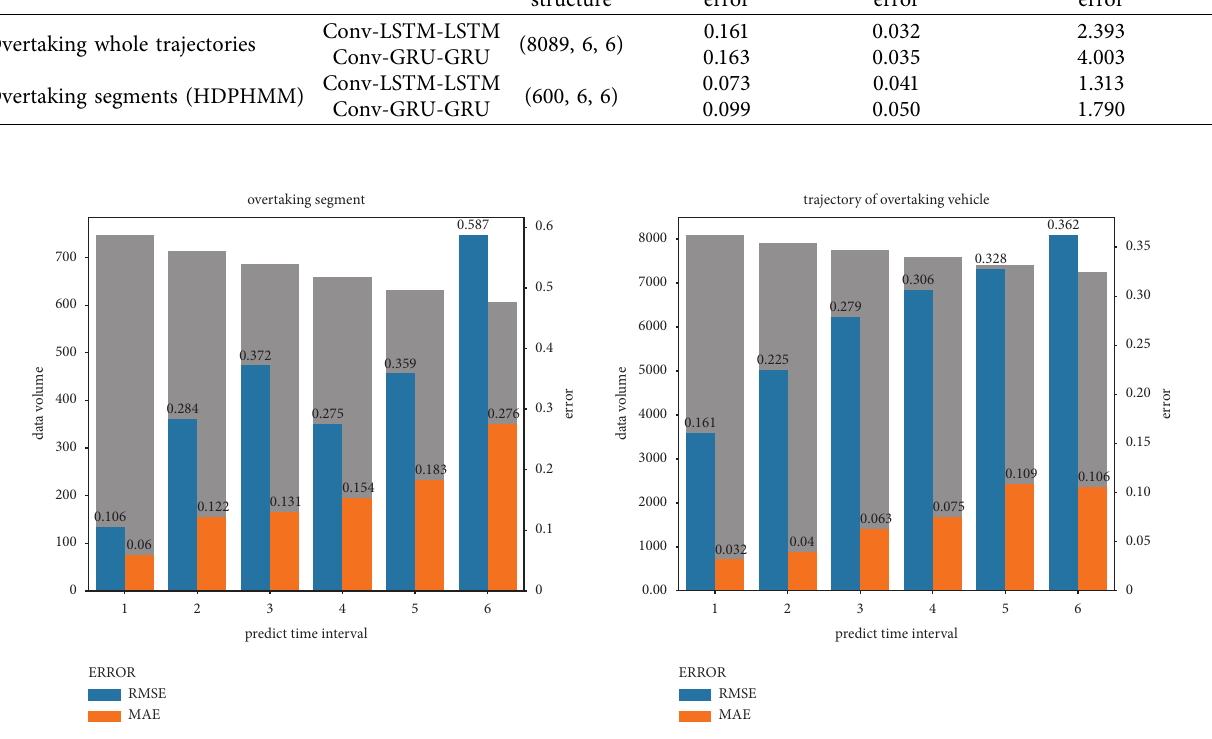
Table 5: Comparisons of complete trajectory of overtaking vehicle and overtaking trajectory segments. Data